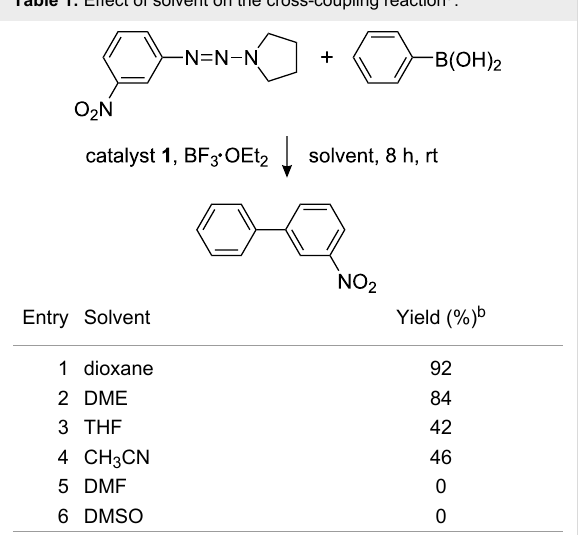
Table 1: Effect of solvent on the cross-coupling reaction a